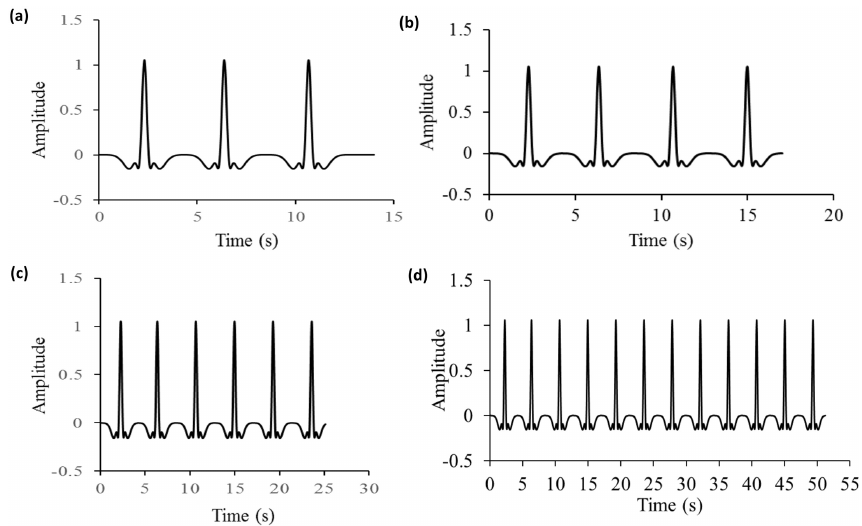
Figure 8. Four signals of changing duration and composed of Ricker wavelets (here with normalized amplitude), corresponding to 14s (a) , 17s (b) , 25s (c) and 51s (d) , were used as seismic